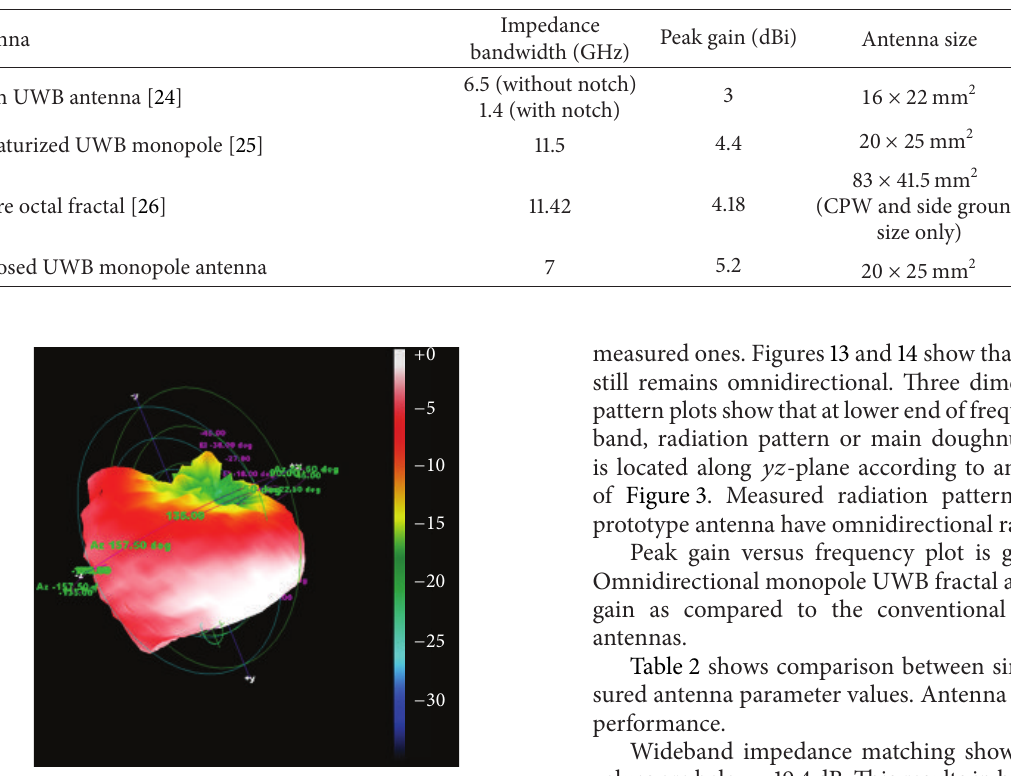
Figure 16: 3D measured radiation pattern at 10GHz.